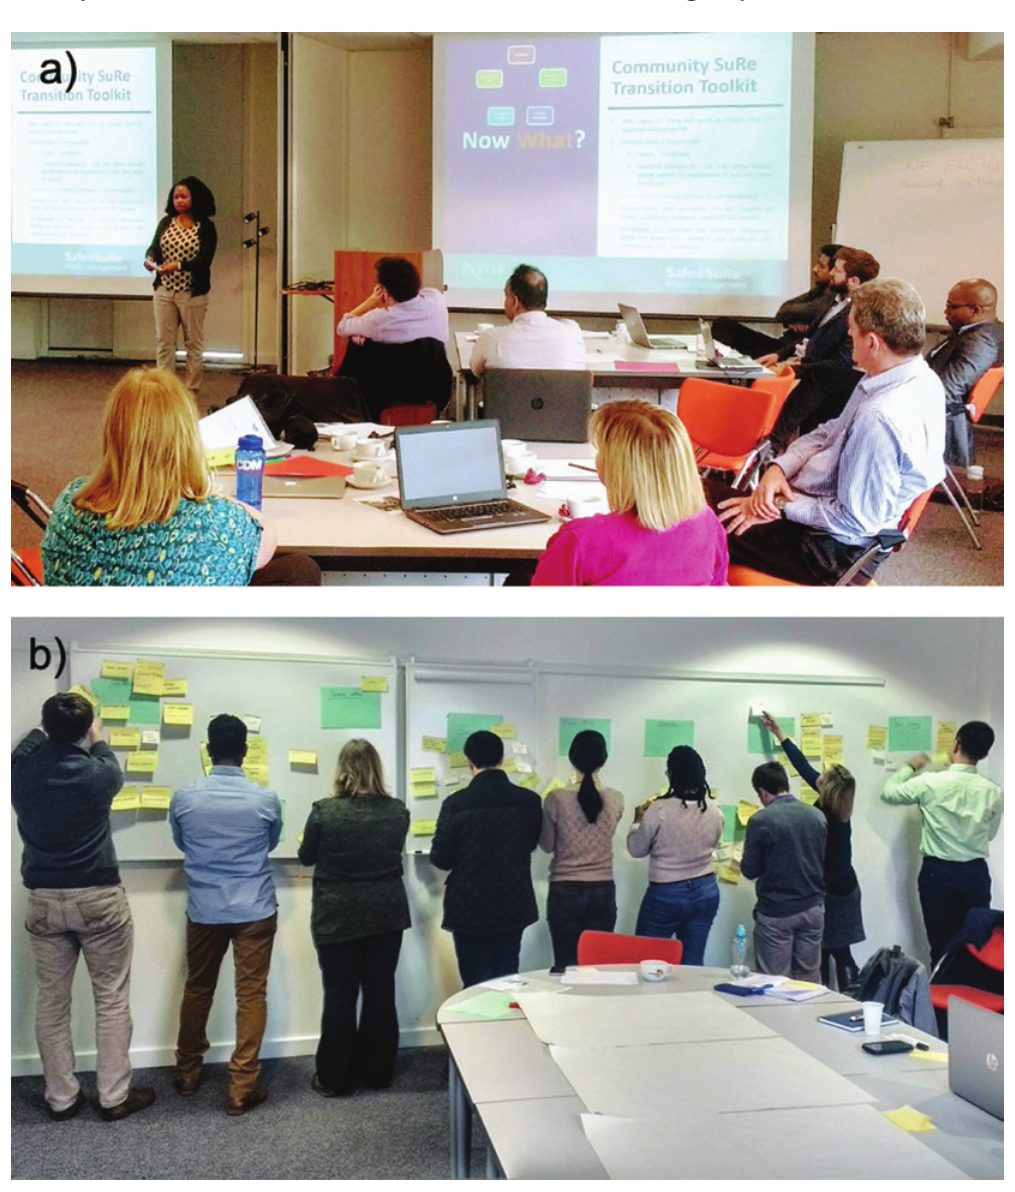
figure 3: steering group meetings were a space to share ideas through exercises such as mind mapping (a), and where researchers and industry could work together on a specific issue, which was then shared with the wider group